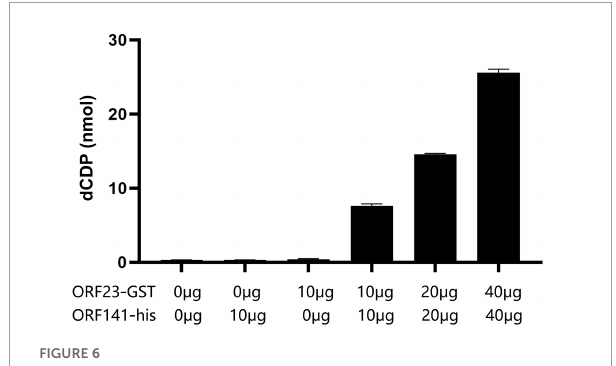
FIGURE6 Ribonucleotide reductase activity assay. The amount of dCDP produced by adding different ORF23 and ORF141 components and different protein